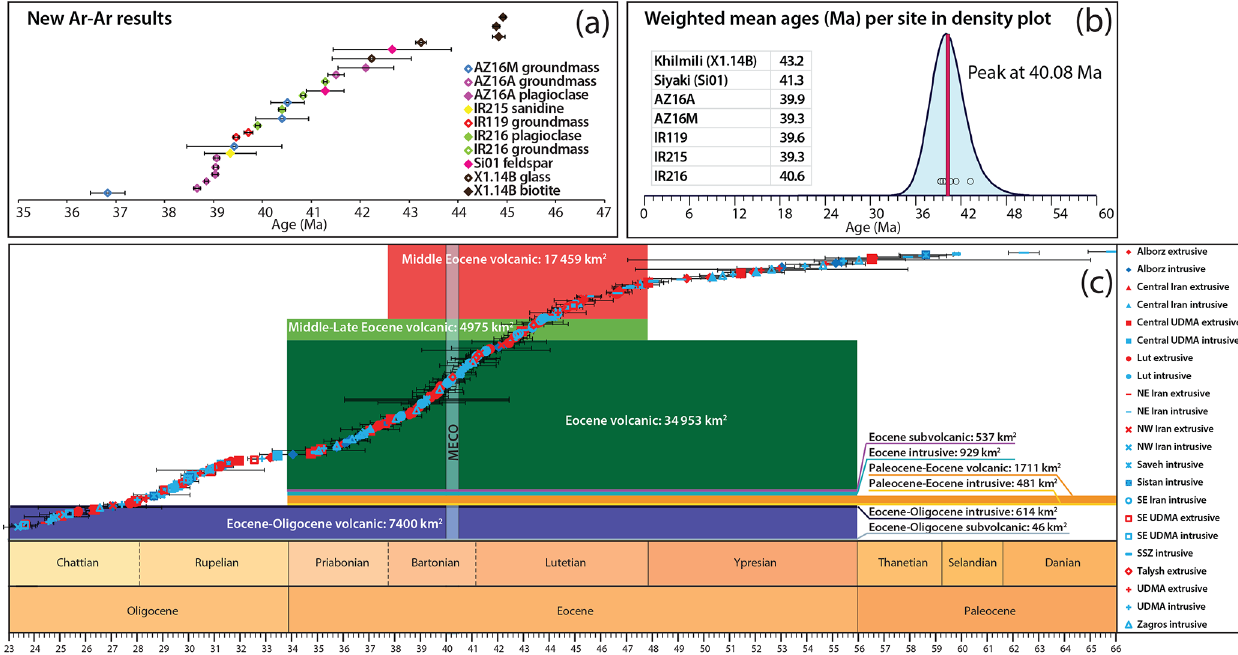
Figure 2. (a) 40 Ar / 39 Ar ages of rocks from northwestern Iran, southern Azerbaijan and the Kura basin with uncertainties (1 σ ). (b) Kernel density plot in blue (Vermeesch, 2012) of combined 40 Ar / 39 Ar ages. The duration and timing of the MECO event is indicated by the pink band. (c) Timescale (created with TS-Creator) with scaled eruptive areas (from Sahandi et al., 2014), color legend for areas is the same as in Fig. 1a. Also plotted are radiometric ages from the literature with associated 1 σ errors, sorted by age. y axis is an arbitrary unit. Red markers represent extrusive ages; blue markers represent intrusive